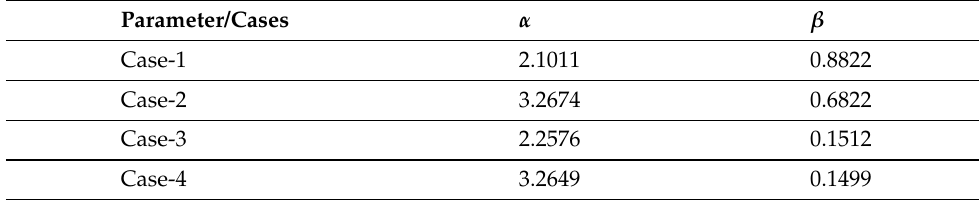
Table 5. Polynomial coefficients generated by the